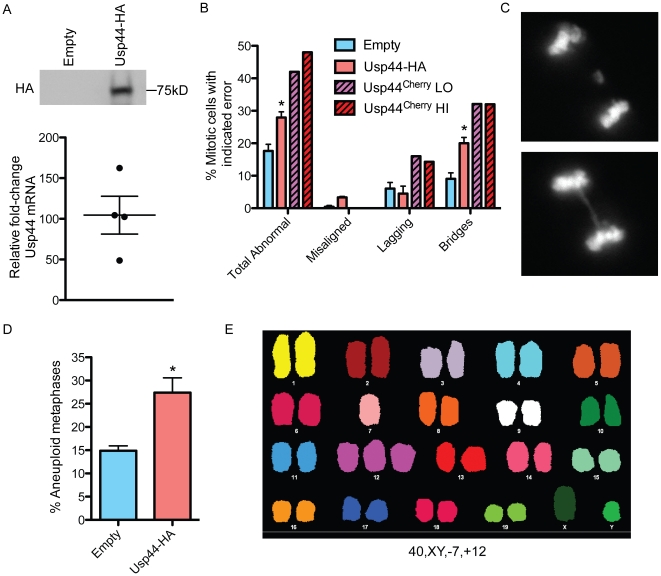
Expression of Usp44 leads to chromosome missegregation and aneuploidy.(a) Expression of Usp44-HA in MEFs as seen by immunoblotting (upper) or quantitative real-time (qRT)-PCR (lower). Four independent MEF lines were transduced with Usp44-HA or Usp44Cherry followed by TaqMan qRT-PCR. Expression was normalized to GAPDH, and fold-change was calculated using the ΔCt method. (b) MEFs stably transduced with either empty vector (n = 78 cells), Usp44-HA (n = 106 cells), or Usp44Cherry (n = 53 total) were analyzed by live-cell microscopy through the indicated numbers of un-perturbed cell divisions. Chromosomes were visualized by transduction with lentivirus encoding histone H2B fused with yellow fluorescent protein (H2B-YFP). The results depict the average and standard error from three-independent MEF lines. (c) Example of a cell with a lagging chromosome (upper) and anaphase bridge (lower). (d) Karyotype analysis of low passage MEFs. Stable transduction with the indicated lentivirus was performed at passage 2. N (metaphases)  = 175 (Empty vector control) and 223 (Usp44-HA) from a total of four independent MEF lines per genotype. (e) Representative spectral karyotype (SKY) of a cell expressing Usp44-HA. Note this cell has a normal chromosome number (40) but has a trisomy of chromosome 12 and monosomy of chromosome 7. * p<0.05 calculated with the unpairted t-test. Error bars represent the SEM.